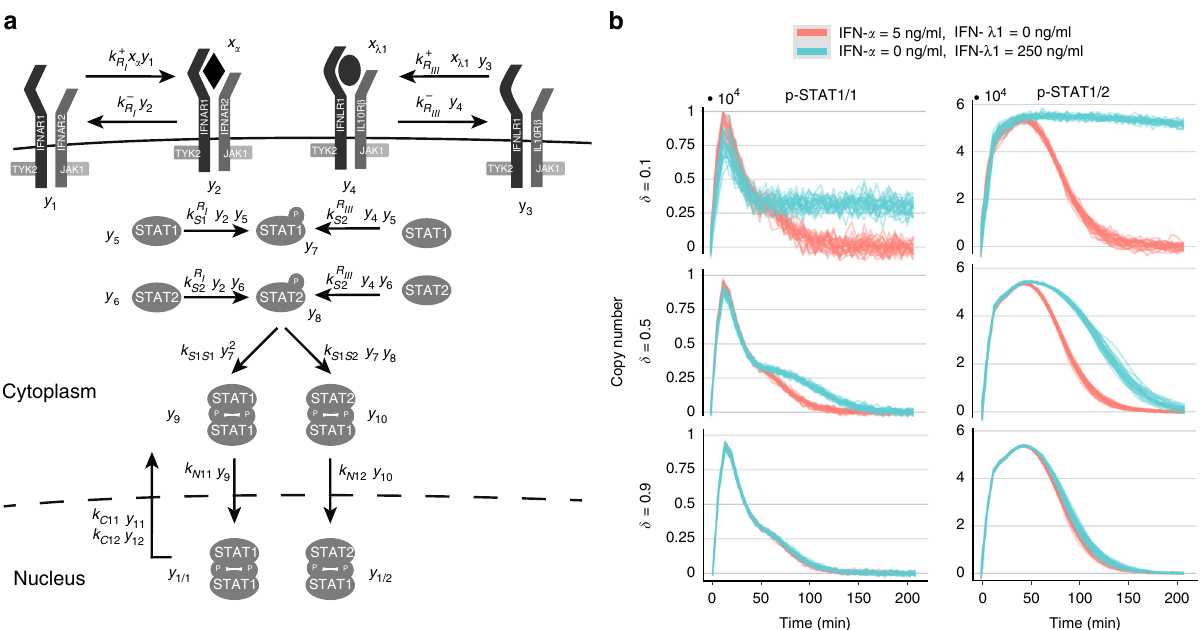
Fig. 3 IFN- α and IFN- λ 1 activate the same signaling effectors but induce different signaling dynamics. a Model representation of the type I and type III IFNs signaling used to construct the input – output probability distribution, P ( Y | X ). IFN- α exerts its action through cognate two subunits receptor complex IFNAR1/IFNAR2, whereas IFN- λ 1 signals through two subunit receptor complex IFNLR1/IL10R α . Both of receptor complexes are pre-associated with JAK1 and TYK2 tyrosine kinases 50,51 . Simplistically, receptor ligand binding results in tyrosine phosphorylation of STAT1 and STAT2 proteins. These, denoted as p-STAT1 and p-STAT2, respectively, form p-STAT1/1 homodimers and p-STAT1/2 heterodimers and translocate to the nucleus. Dephosphorylation in the nucleus results in nuclear export of STATs and makes them available to subsequent phosphorylation/dephosphorylation cycles. b Samples of the model output Y (copy numbers of nuclear p-STAT1/1 and p-STAT1/2 dimers) in response to 30 min stimulation with IFN- α (green; 5 ng/ml) or IFN- λ (red; 250 ng/ml) for three levels of δ and c v = 0. In each panel 30 trajectories are plotted. Parameters used to simulate the mode are given in Supplementary Tables 1 and